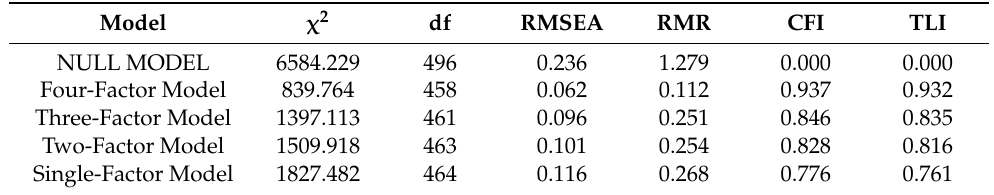
Table 3. Results for confirmatory factor analysis.